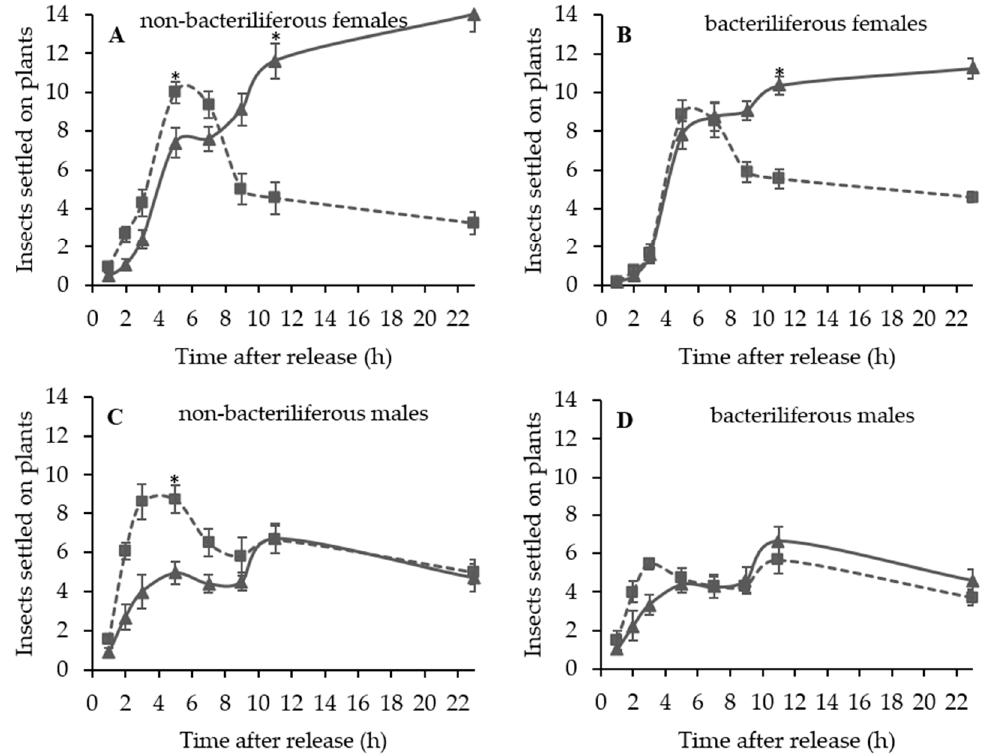
Figure 3. Average number ( ± SEM) of Dalbulus maidis adults on leaves of healthy “mock-inoculated” (solid line) vs. maize bushy stunt phytoplasma (MBSP)-infected symptomatic (dotted line) maize plants, at successive time periods after insect release in the choice arena. ( A ) Non-bacteriliferous females; ( B ) Bacteriliferous females; ( C ) Non-bacteriliferous males; ( D ) Bacteriliferous males. Means at 5 and 9 h after release were compared by t -test and the asterisk (*) represents statistical difference ( p < 0.05). 3.3. Adults of D. maidis Acquire and Transmit MBSP after 6 h AAP on Symptomatic